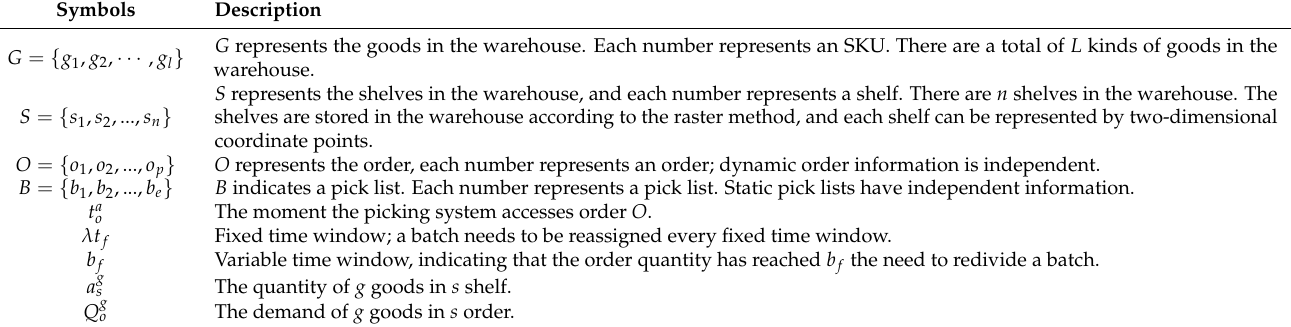
Table A1. Symbols description of model static picking order to determine the target shelf (see Section 2.4).